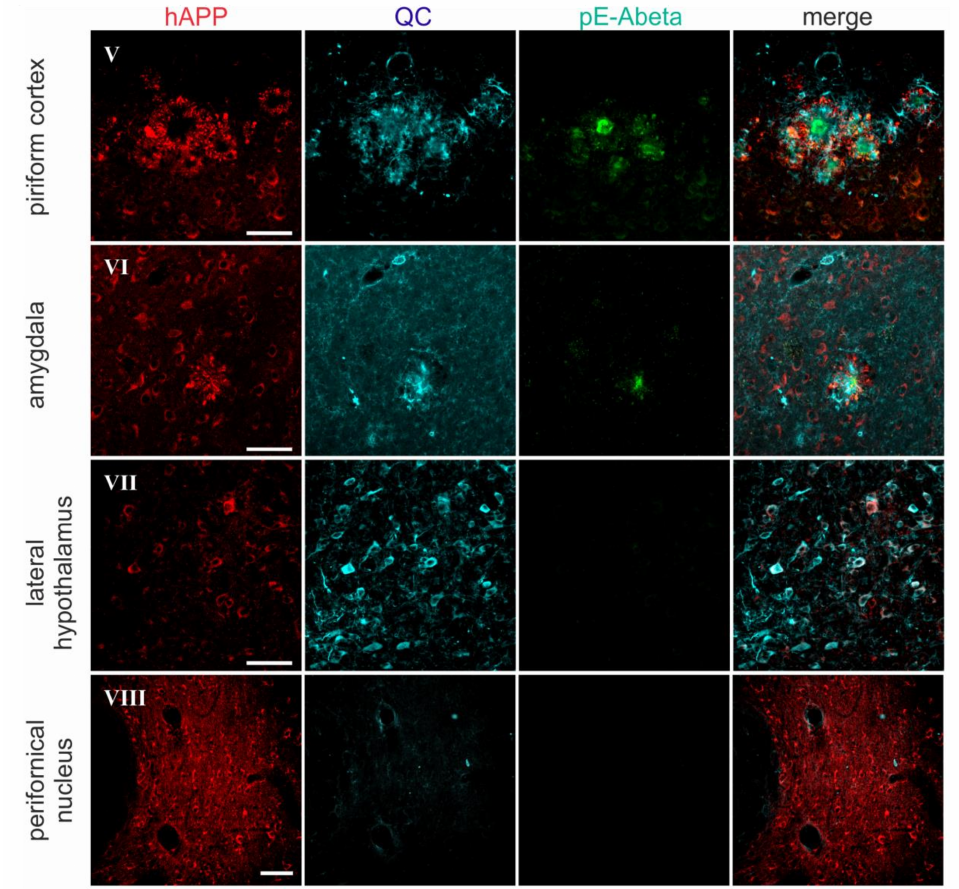
Figure 4. Triple immunofluorescent labeling of hAPP, QC, and pE-Abeta. hAPP, QC, and pE-Abeta were visualized by triple immunofluorescent labeling with secondary antibodies from donkey resulting in red (hAPP), blue (QC), and green (pE-Abeta) labeling. Roman numerals I-VIII correspond with the numbers in Figure 3 and indicate the areas of interest. Scale bars represent 50 µ